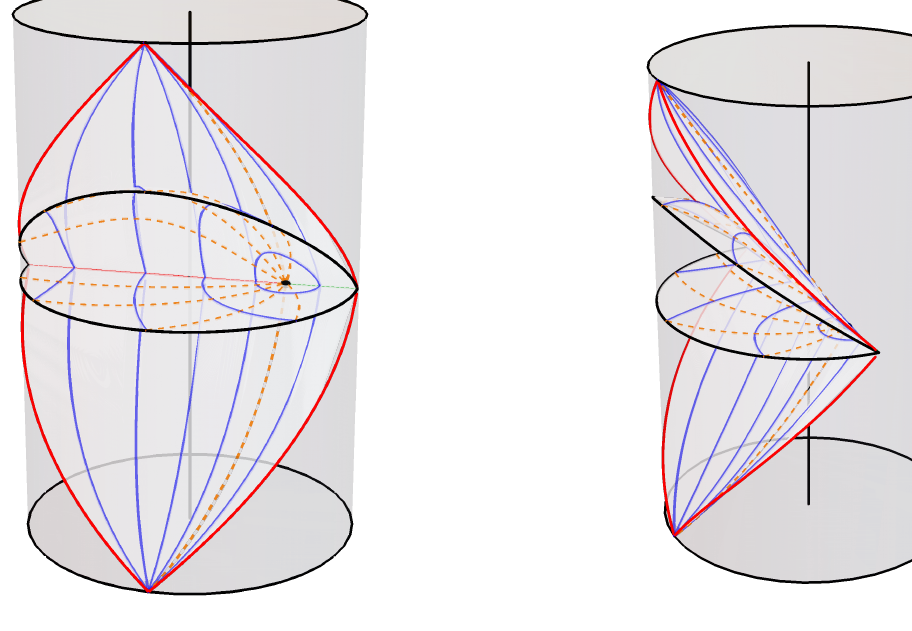
Figure 26 . The Class III solution. Several surfaces of constant τ are shown, with those at very early and very late times outlining the two disjoint bifurcate Killing horizons. The red bifurcation surface is y = − y h , while the green bifurcation surface is y = + y h . The black dot denotes the point x → ∞ . Lines of constant finite x are shown in solid blue, with lines of constant y shown in dashed